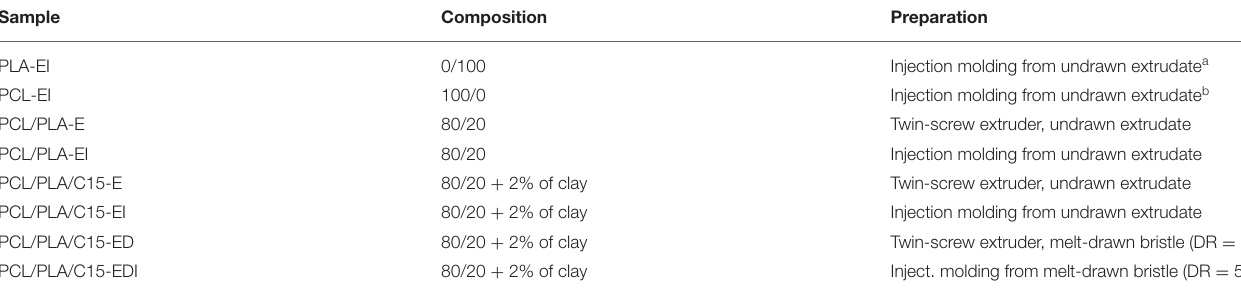
TABLE 1 | List of investigated